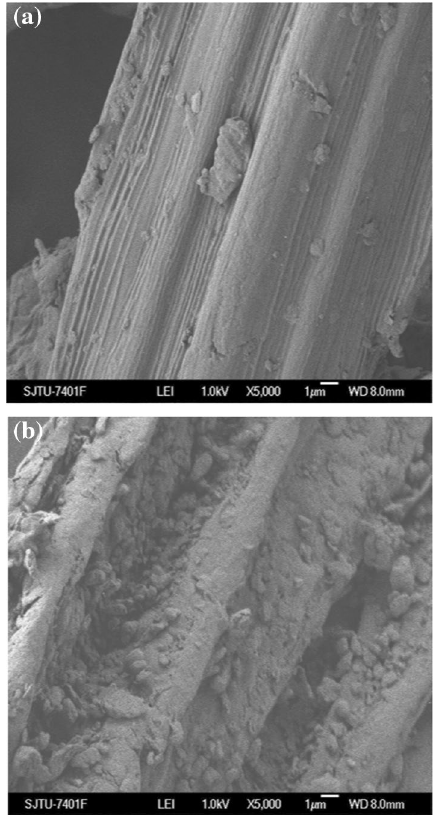
Figure 2. ( a ) SEM images of WS before pretreated with NaOH; ( b ) SEM images of WS after pretreated with NaOH under optimal